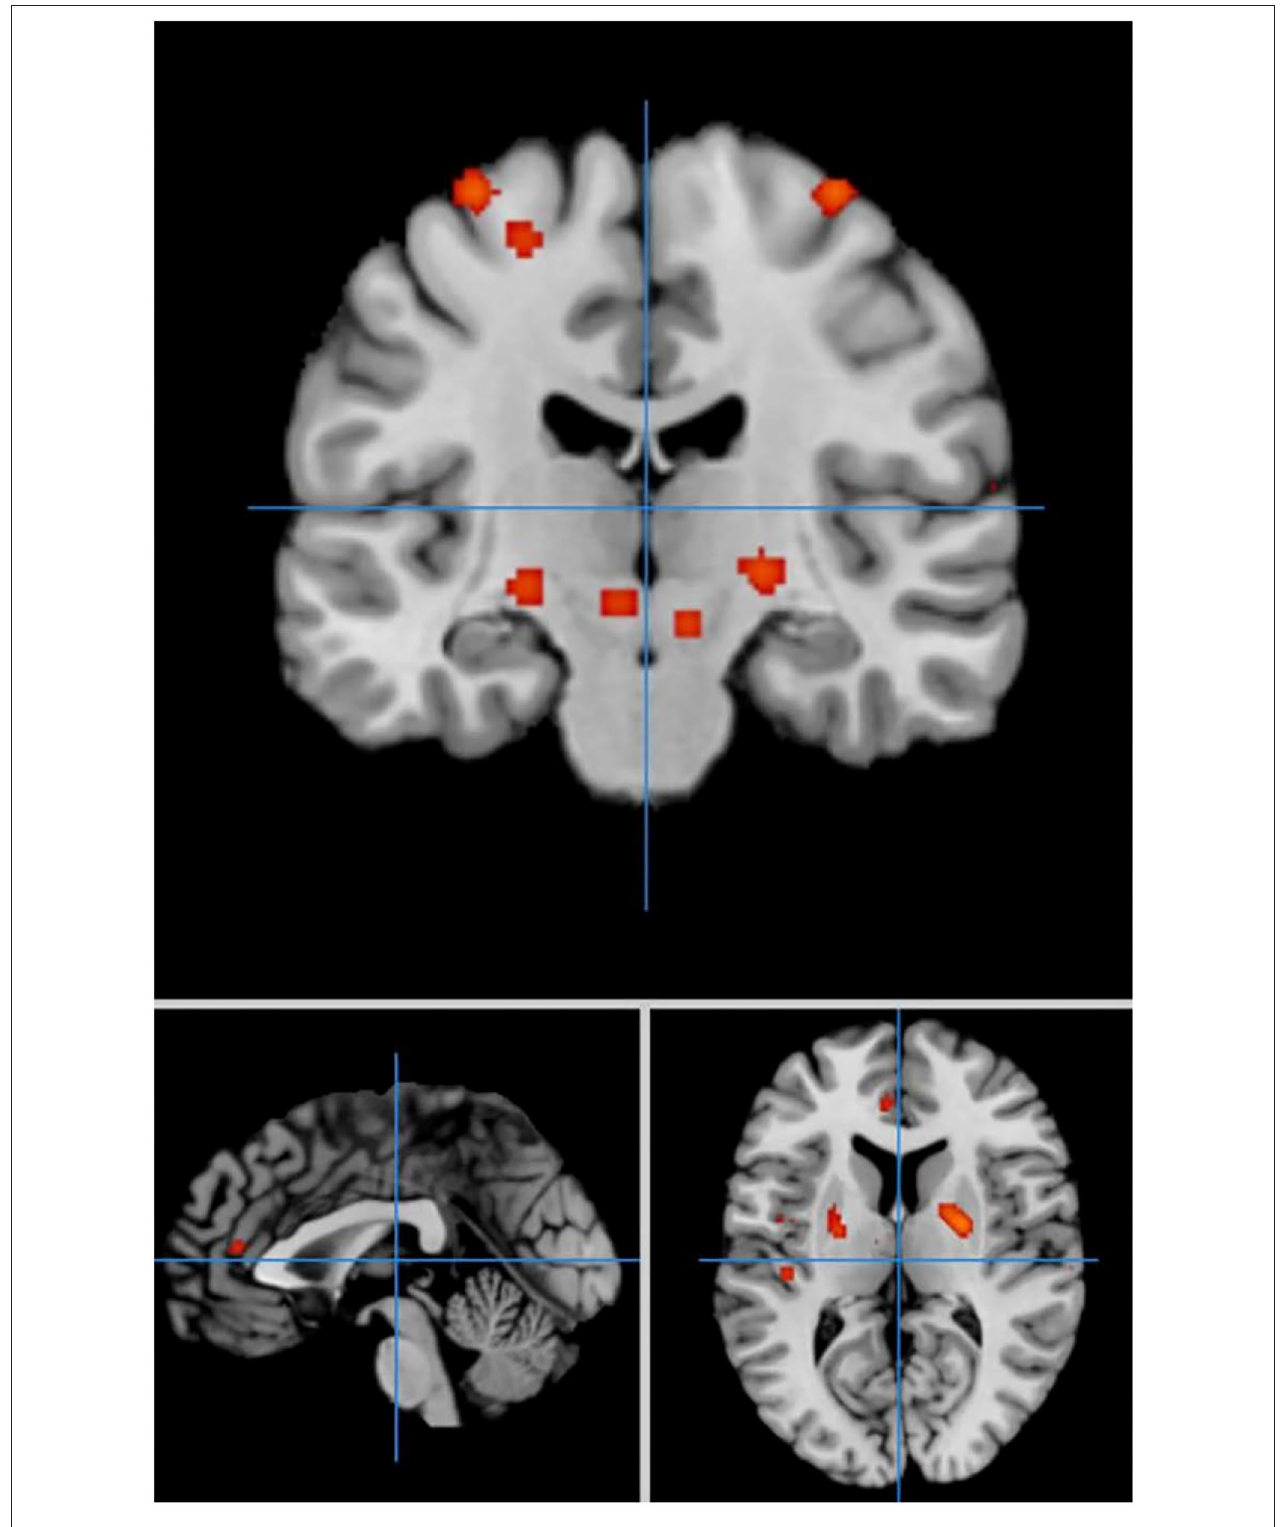
FIGURE 5 | Significant clusters with HC > PD activation in the ALE meta-analysis in self-priming conditions.